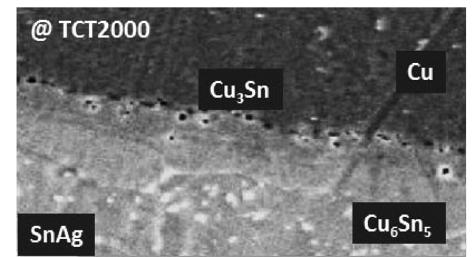
Figure 7. Cu 6 Sn 5 and Cu 3 Sn